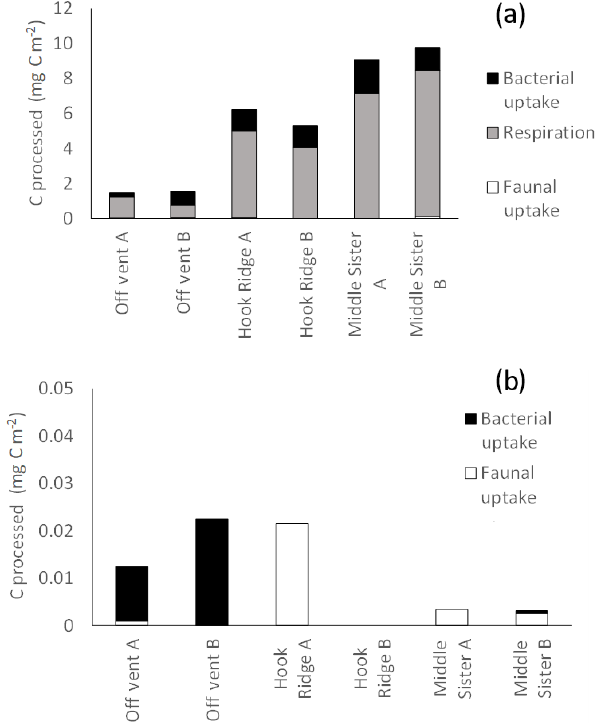
Figure 8. Total biological C processing during the (a) algae addition experiments and (b) bicarbonate addition experiments. The absence of data represents the combination of the lack of sample and an undetectable faunal 13 C